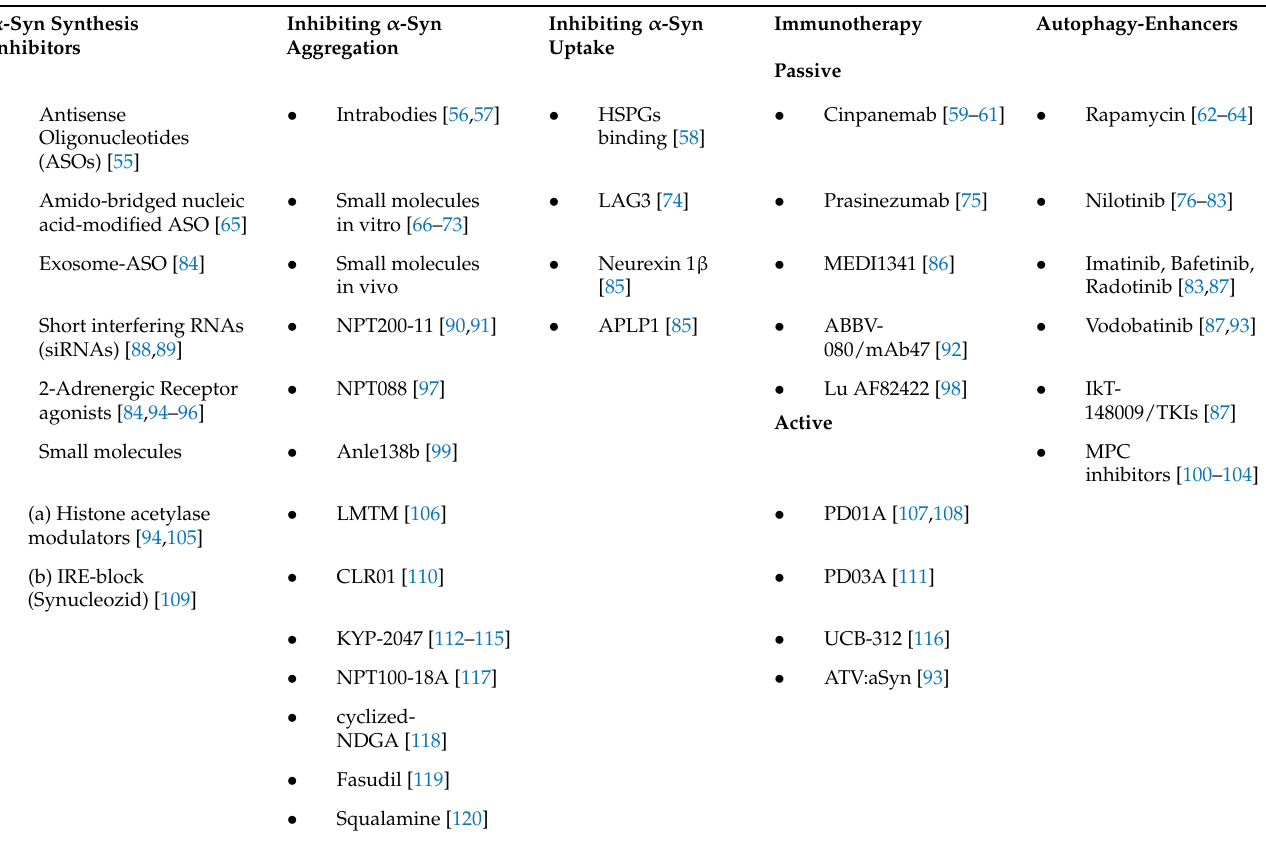
Table 1. Potential disease-modifying therapeutic strategies targeting α -Synuclein studied in synucle- inopathies so